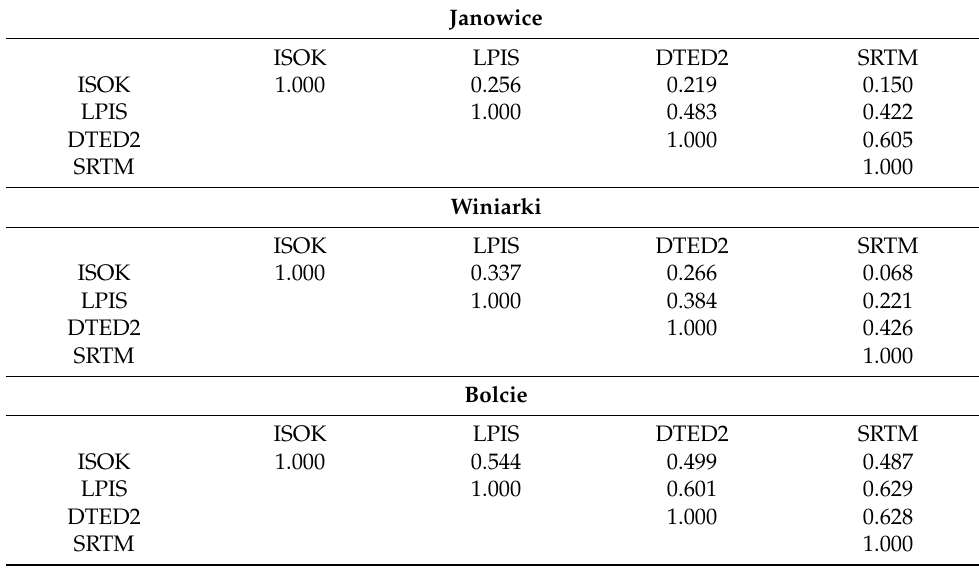
Table 15. The summary of the Pearson correlation coefficient values for the maximum of the total LS factor values on the basis of the 4 DTM sources for the agriculture plots in the 3 research